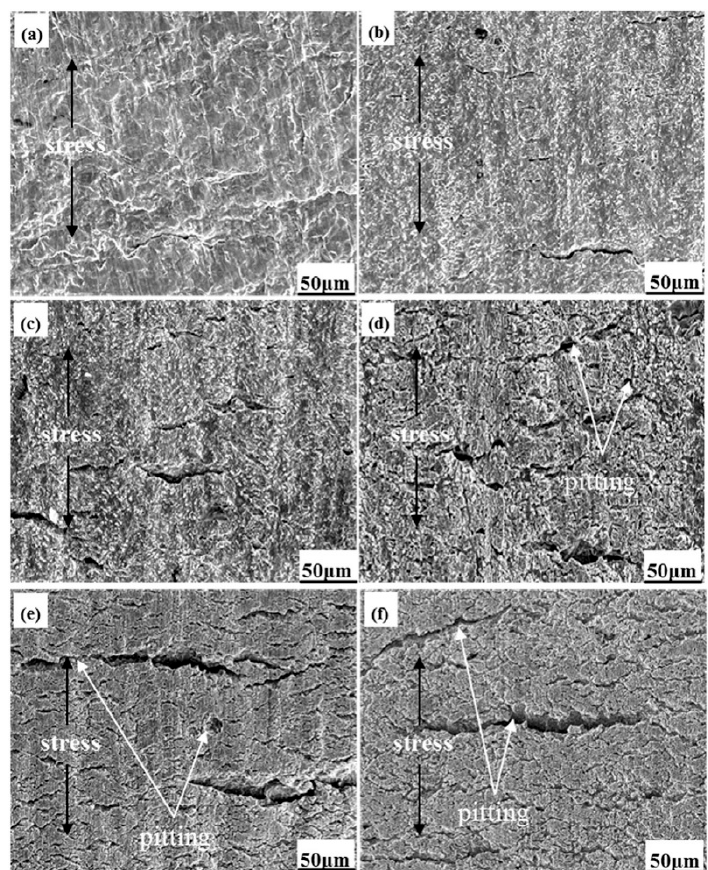
Figure 9. SEM image of fracture surfaces of X80 pipeline steel in air and NS4 solution in ( a ) in air, ( b ) 0 A / m 2 , ( c ) 5 A / m 2 , ( d ) 10 A / m 2 , ( e ) 30 A / m 2 and ( f ) 50 A / m 2 [42]. Reproduced with permission from [42], Elsevier, 2017.